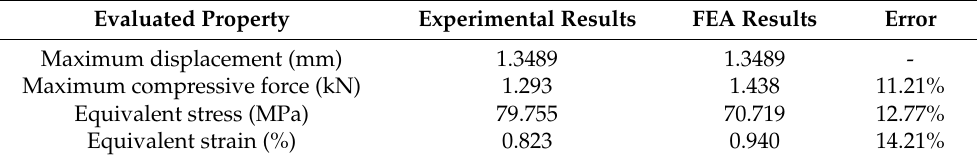
Table 11. Comparison between the FEA and experimental results for the CPE CF112 honeycomb.